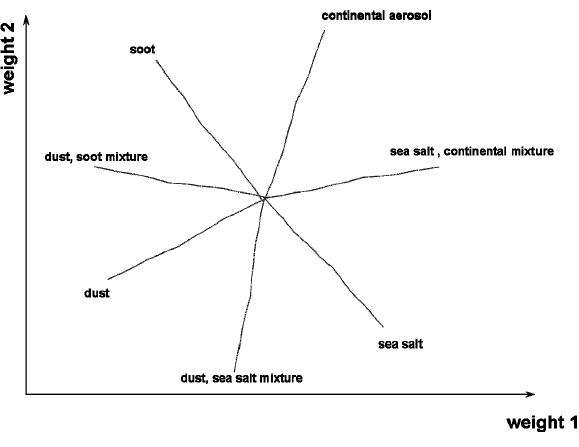
Fig. 7 Distribution of aerosol models in the space of first and second weights in perfect case of the retrieval. Fig. 7. Distribution of aerosol models in the space of first and sec- ond weights in perfect case of the